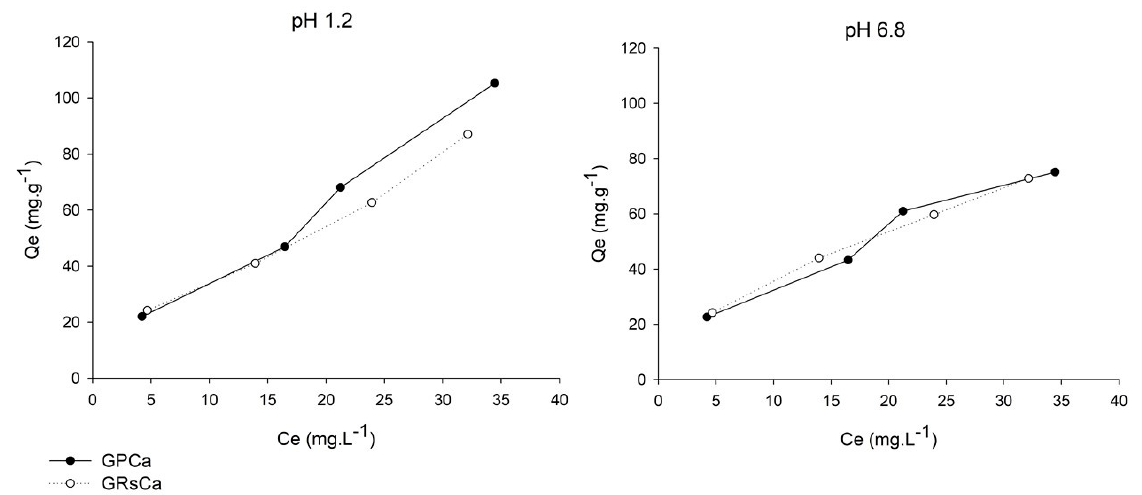
Figure 7. Mucin adsorption curves of microparticles in mediums of pH 1.2 and